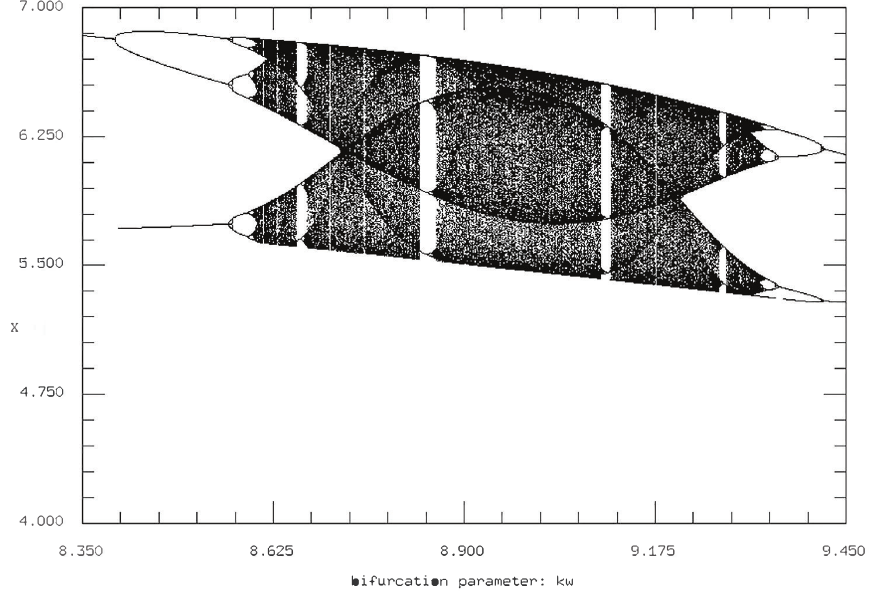
Figure 10. Bifurcation diagram of maxima of X for k w and k f = 0, k fm = 0 and other parameters from Table